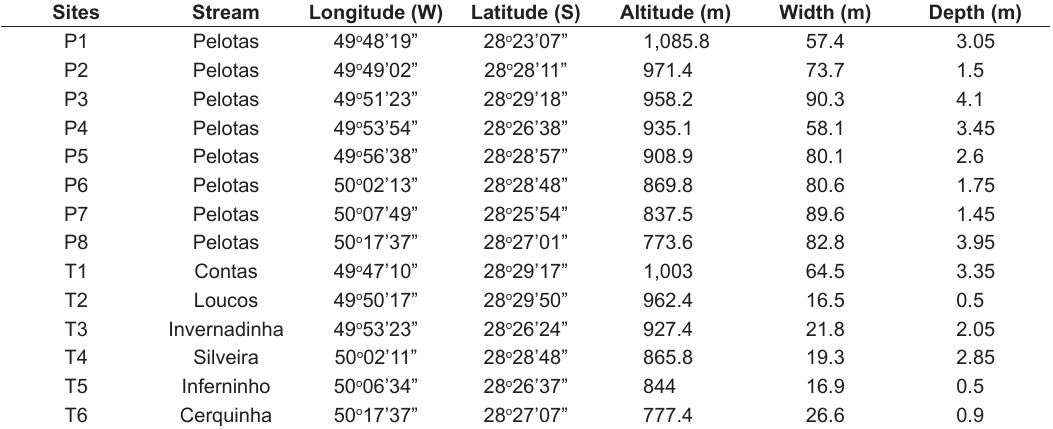
Table 1. Features of the sampled sites in seven streams of the Pelotas River sub-basin, states of Santa Catarina and Rio Grande do